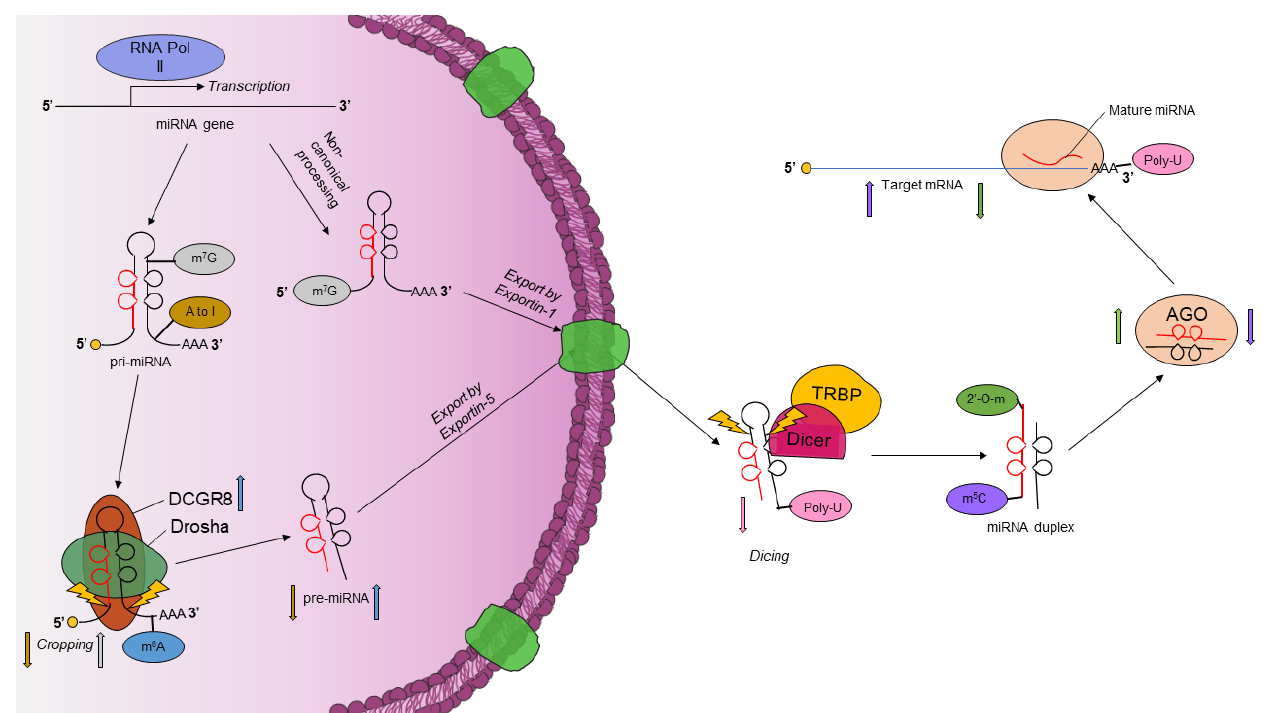
Figure 1. Epitranscriptomic modifications regulate the maturation and downstream targeting of miRNAs. A-to-I editing interferes with Drosha processing, inhibiting the processing of pri-miRNAs to pre-miRNAs (brown arrows). m 7 G (grey arrows) disrupts the formation of inhibitory G-quadruplexes in the pri-miRNA and facilitates miRNA processing. A group of m 7 G-capped miRNAs undergo a non-canonical biogenesis pathway, bypassing Drosha processing and being exported by exportin-1. m 6 A enhances DCGR8 binding to pri-miRNAs to enhance miRNA processing (blue arrows). m 5 C impairs mRNA/miRNA complex formation, affecting miRNA targeting (purple arrows). Poly-U blocks Dicer cleavage and marks the pre-miRNA for degradation (pink arrows). Poly-U is added to the miRNA- directed cleaved mRNA for 5′ degradation. 2′ -O- methyl protects the 3′ end of miRNA from degradation and enhances AGO2 binding, increasing target repression by miRNAs (green arrows).